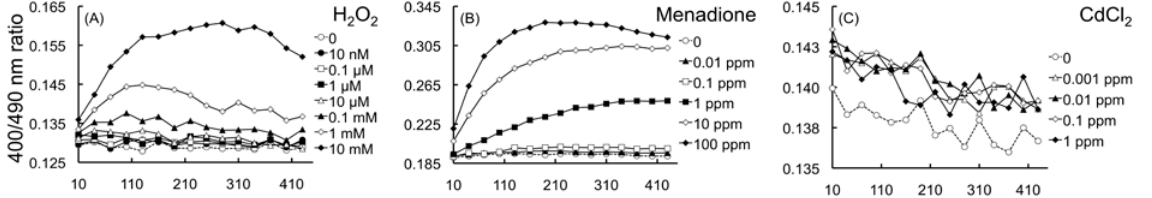
Figure 3. Multi-well ratiometric kinetic analysis of cellular oxidation using E. coli -roGFP2. O (A), menadione (B), CdCl Exposure to several concentrations of H 2 2 Pb(CH COO) (E), ZnCl (F), Na SeO (G), NaAsO (H), ZnPT (I), TPT (J) 3 2 2 2 3 2